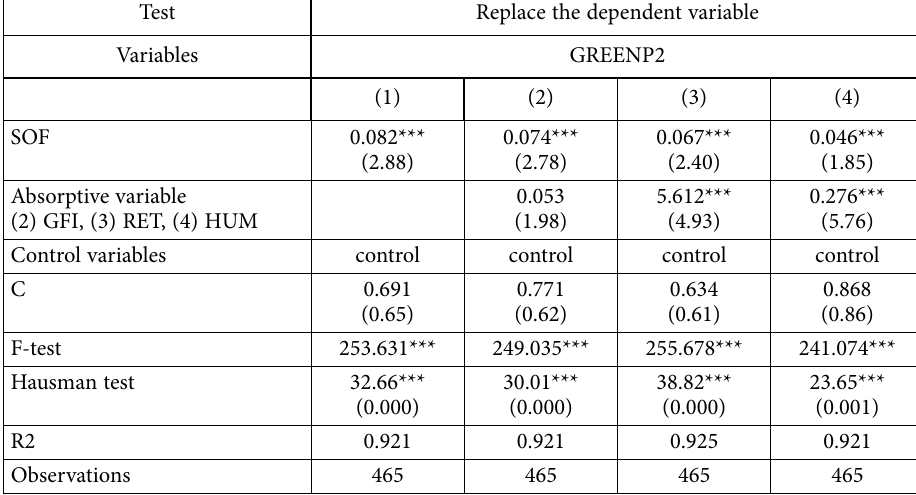
Table 4. Result of robustness